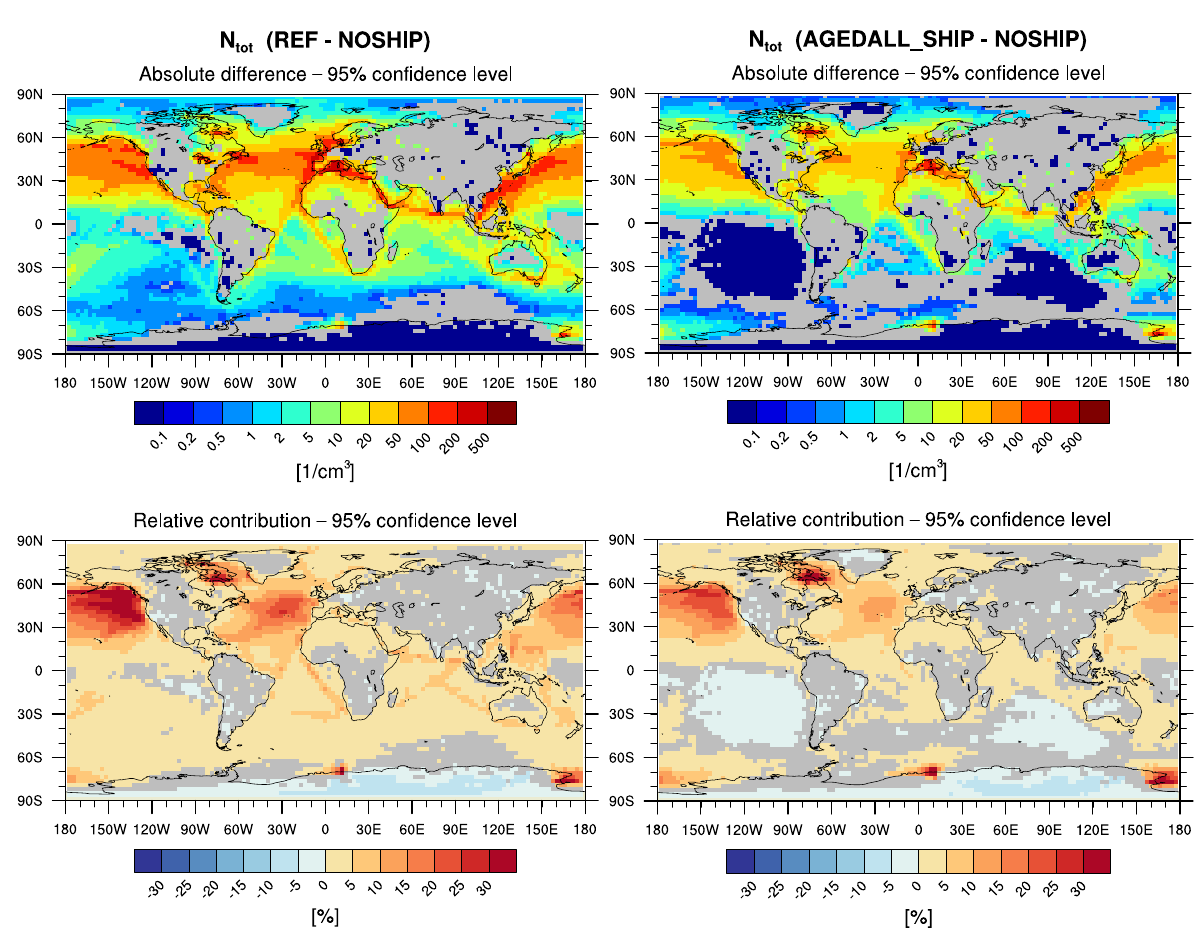
Fig. 10. Multi-year average (1996–2005) of the absolute (top) and the relative effect (bottom) of shipping on the Aitken and accumulation mode number concentration at the surface. Plotted are the differences between the experiments AGED2_SHIP (REF) and NOSHIP (left) and between AGEDALL_SHIP and NOSHIP (right). The relative effect is calculated as the relative contribution (REF–NOSHIP)/REF (left) and (AGEDALL_SHIP–NOSHIP)/AGEDALL_SHIP (right). Grid points where the difference is not statistically significant according to a uni-variate t test (5% error probability) are masked out in